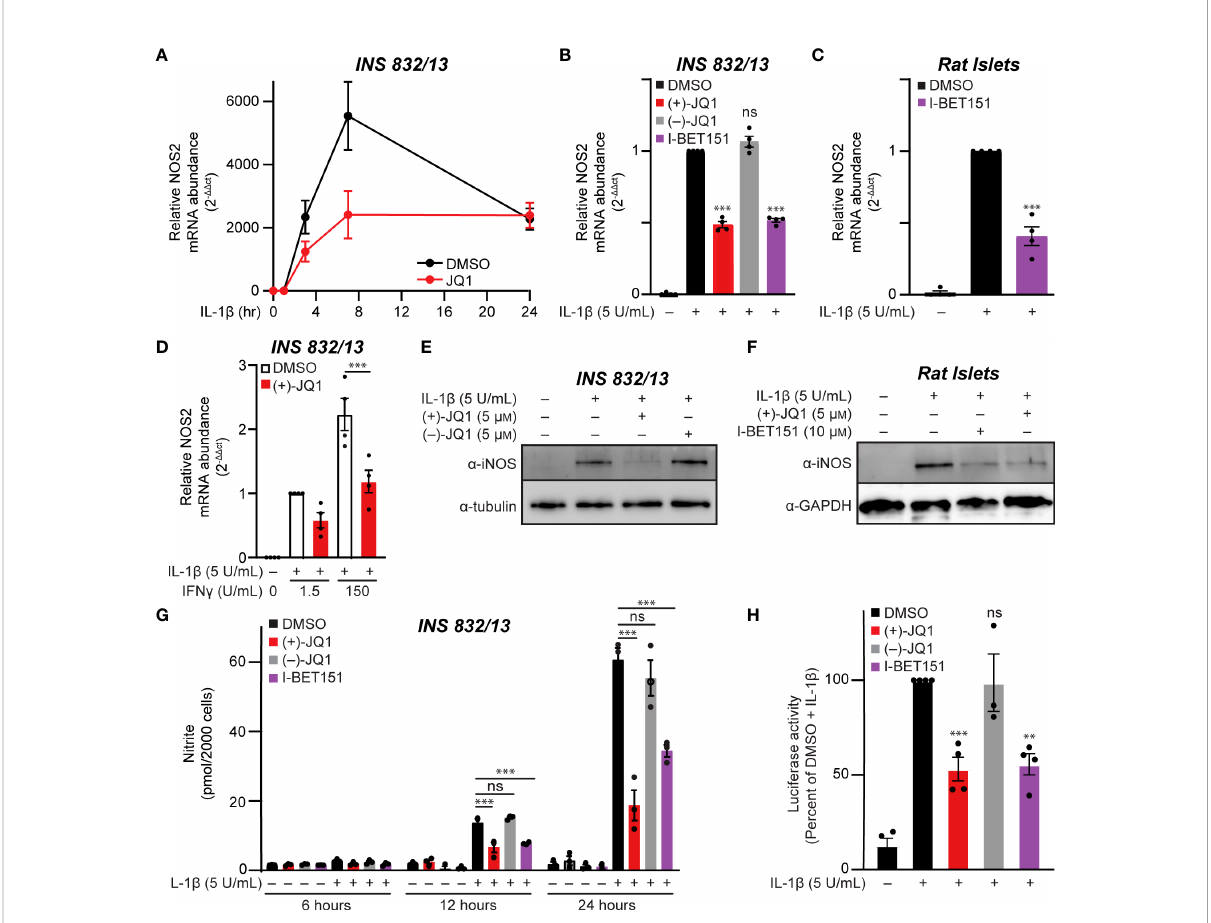
FIGURE 1 Pan-BET bromodomain inhibition mitigates IL-1 b -induced transcription of NOS2 , iNOS protein production, and nitrite accumulation in pancreatic b -cells. (A) RT-qPCR analysis of NOS2 transcript levels in INS 832/13 cells treated for 1 hour with 0.5 m M (+)-JQ1 followed by 5 U/mL IL-1 b exposure for 1, 3, 7, or 24 hours. (B) RT-qPCR analysis of NOS2 transcript levels in INS 832/13 cells treated for 1 hour with 0.5 m M (+)-JQ1, 0.5 m M ( – )-JQ1, 1 m M I-BET151, or DMSO followed by addition of 5 U/mL IL-1 b for 3 hours. (C) RT-qPCR analysis of NOS2 transcript levels